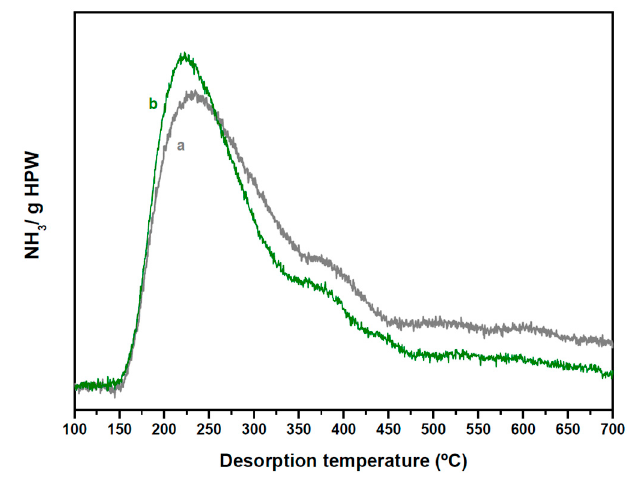
Figure 10. TPD-NH 3 profiles of reduced CZA-xHPW/TiO 2 hybrid catalysts: CZA-1.4HPW/Ti (a) and CZA-2.7HPW/Ti (b). Catalysts 2020 , 10 , x FOR PEER REVIEW 13 of 23